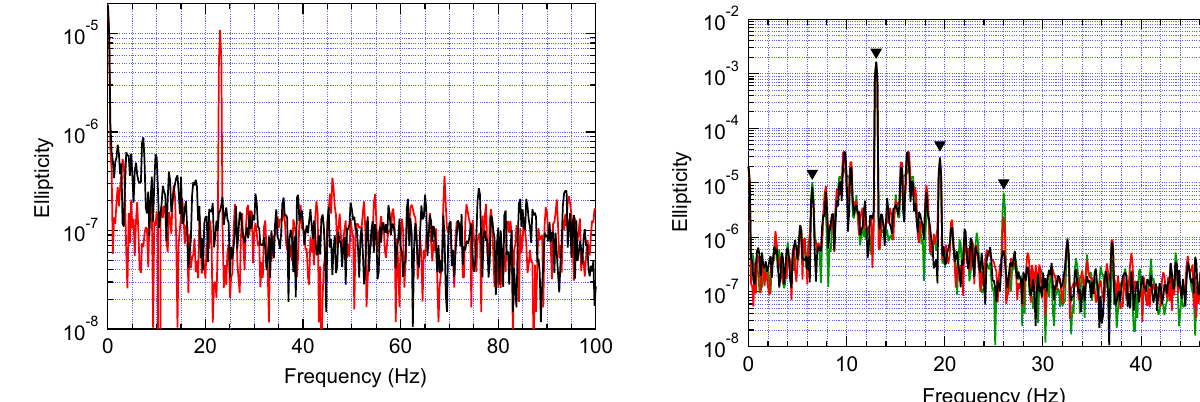
Fig. 7 Demodulated ellipticity spectra of the zero-wave GP rotating at ν P = 6 . 5 Hz. The black triangles mark the first four harmonics of this frequency. The spectrum with the highest fourth harmonics peak has been recorded while modulating the transverse position of the plate at the frequency ν P by ± 30 µ m, with the right phase to maximise the response. For the lowest peak spectrum the modulation has the opposite phase and a 15 µ m amplitude. The intermediate peak spectrum has no modulation (see Fig.